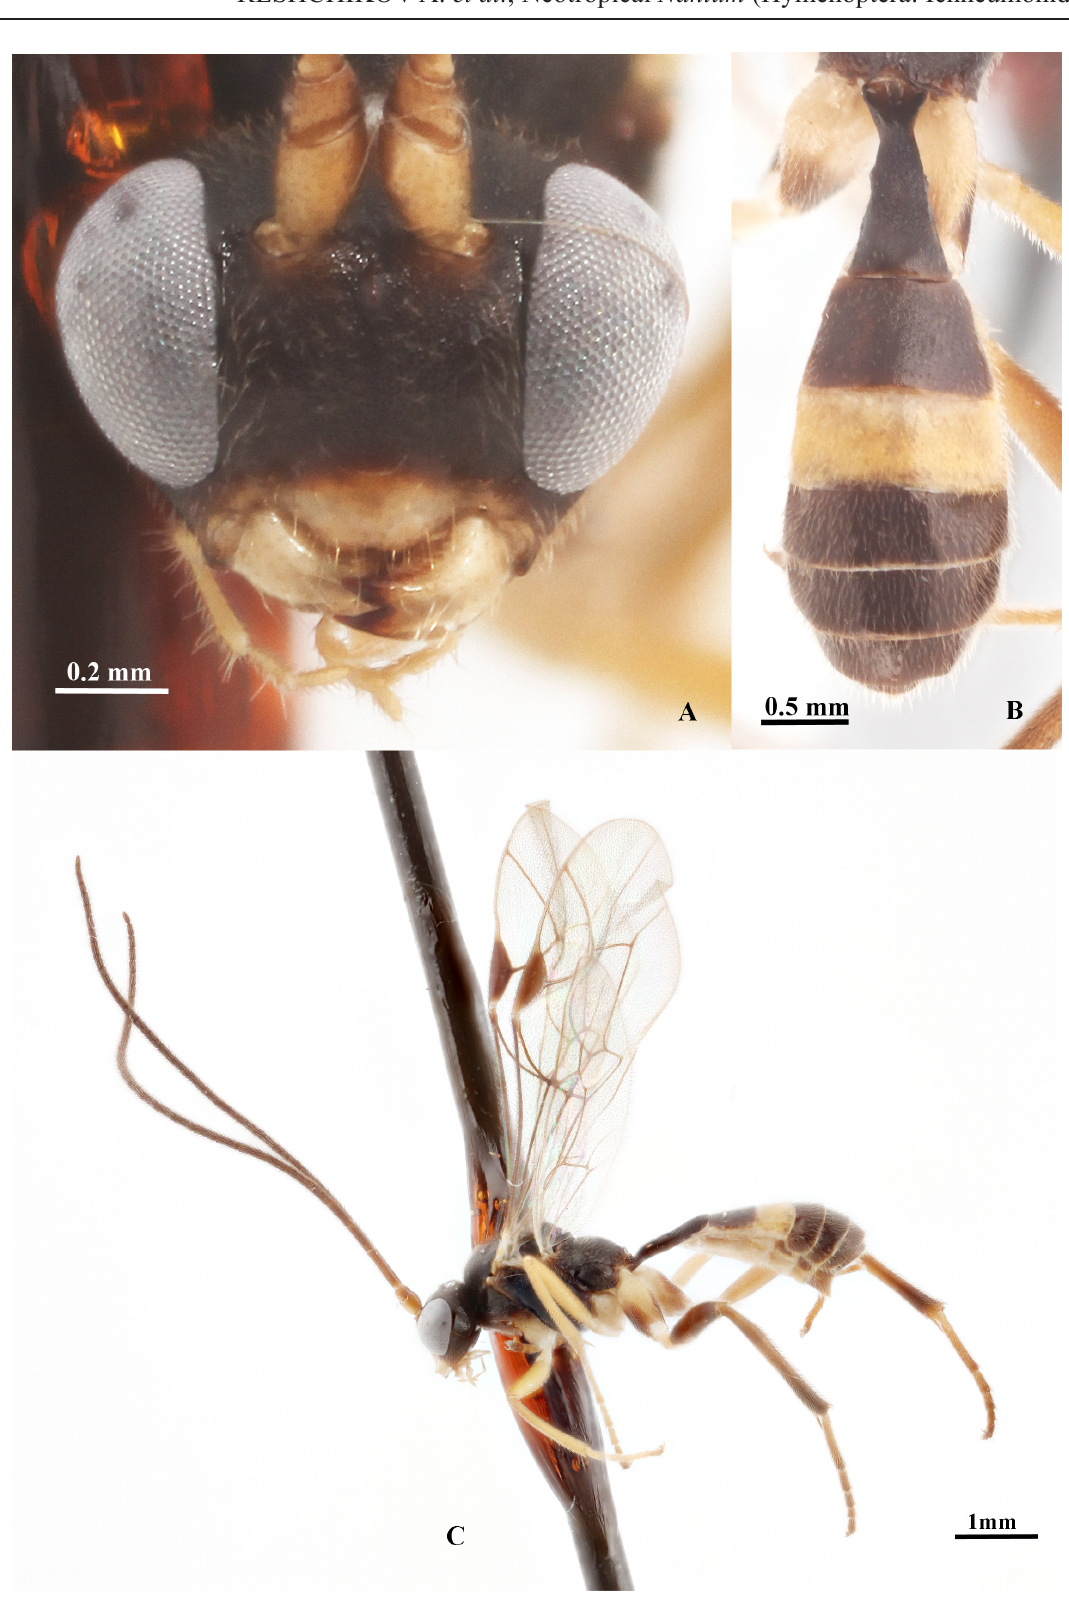
Fig. 1 . Nanium atitlanensis Reshchikov & Sääksjärvi sp. nov. , holotype, ♀ ( LLAMA#Ma-B-09-2-01 (ZMUT)) . A . Face (frontal view). B . Metasoma (dorsal view). C .